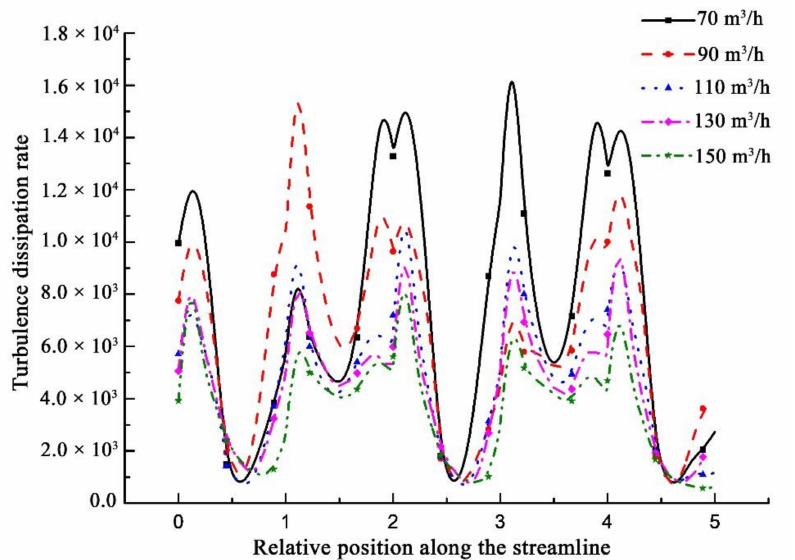
Figure 23. Axial streamline distribution at 0.8 span of the compressor stage.